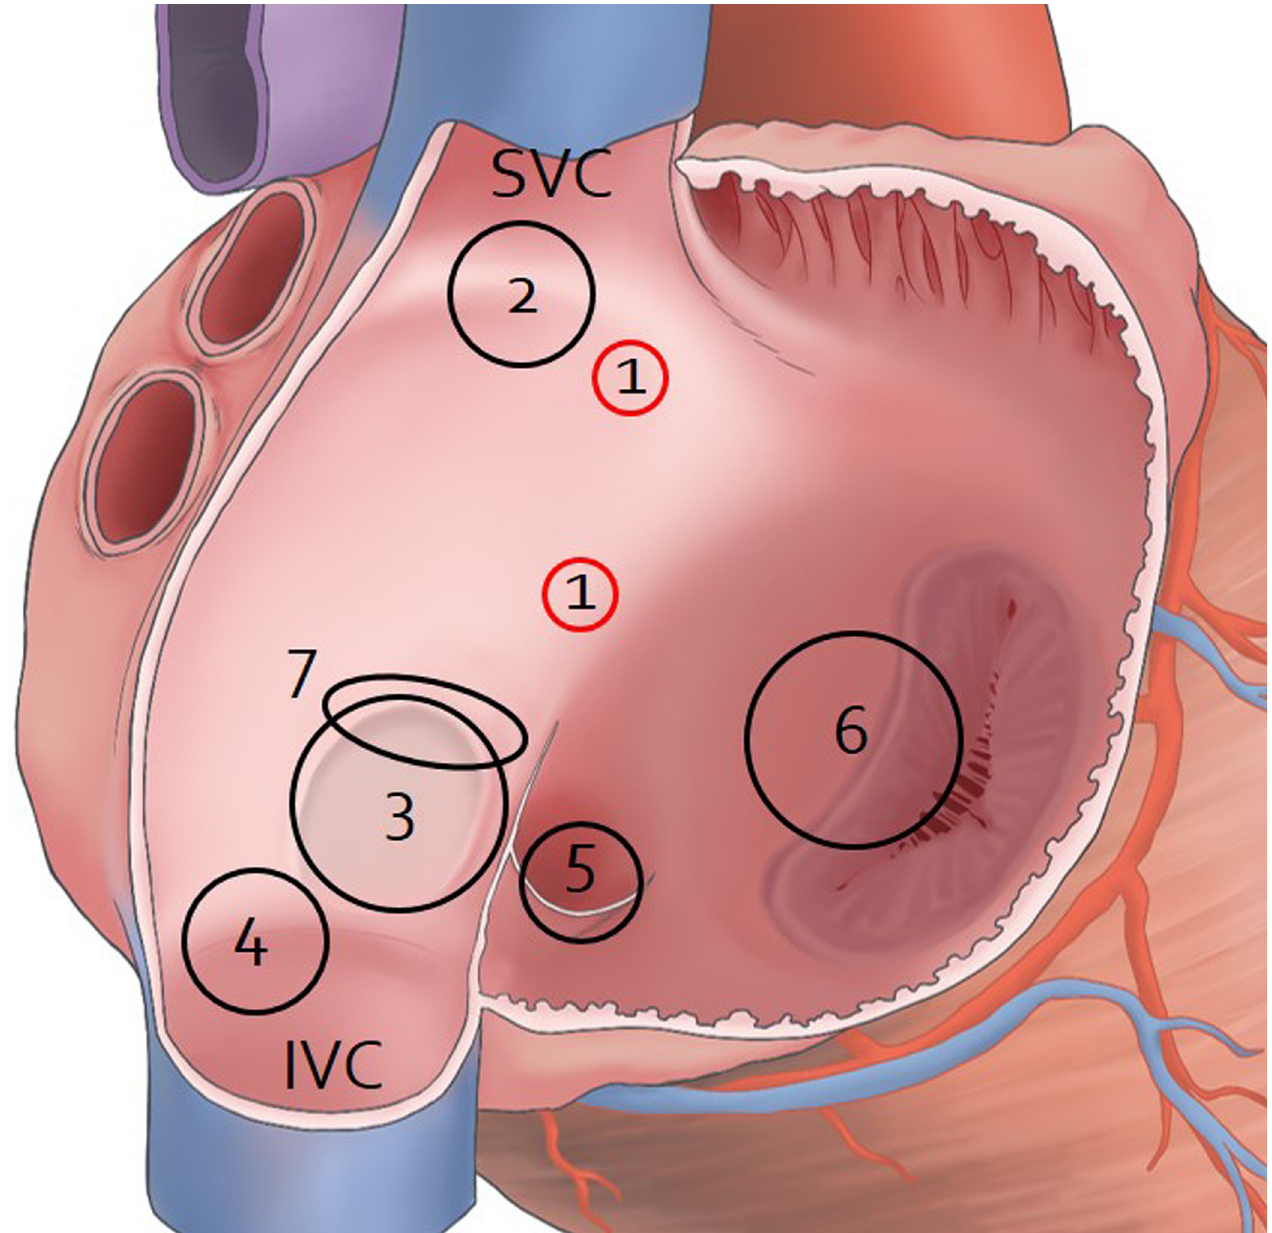
Fig 6. Sites of IAC, atrial ASDs, and PFO on the right surface of the interatrial septum. The right atrium was opened to show holes on the surfaces of the interatrial septum. 1, IAC; 2, Superior sinus venosus ASD; 3, Ostium secundum ASD; 4, Inferior sinus venosus ASD; 5, coronary sinus ASD; 6, Ostium primum ASD; 7, PFO; SVC, superior vena cava; IVC, inferior vena cava. between the free edge of the overlapping ovale fossa valve and its muscular rim [2]. While an ASD involves a hole in the interatrial septum, the IAC has holes of different sizes connected to each other via a tortuous channel. In addition, the lengths of the open IACs in the present study were 14.9 mm and 16.1 mm. A tunnel-like PFO with a channel measuring longer than 12 mm creates complications, and standard closure procedures implemented through the PFO can be unsuccessful [25].